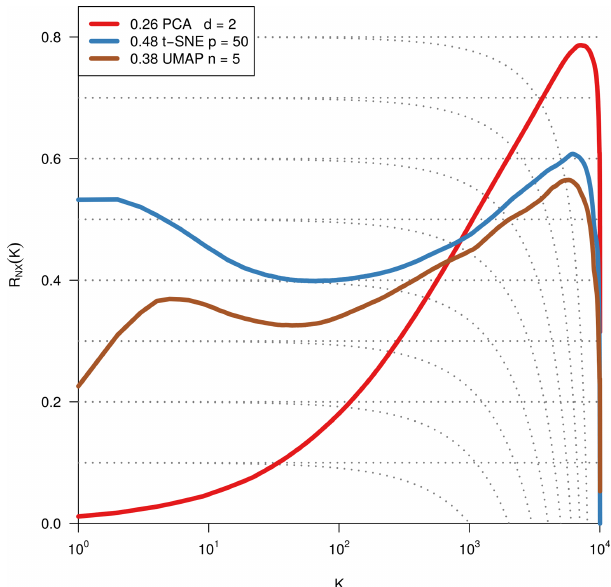
Figure B1. Quality assessment of dimensionality reduction techniques. To visualise and subsequently analyse the network space, we reduce its dimensionality. We compared PCA, t -SNE, and UMAP including various parameter settings (here: PCA’s leading two principal compo- nents, t -SNE with perplexity 30 and UMAP with n neighbours equal to 5 for two dimensions). The test statistic R NX (k) ( y axis) gives the improvement of the embedding of K -ary neighbourhoods ( x axis) over a random embedding. The area under the curves (preserving the log-scaled x axis) is given in the legend and gives an idea of the overall quality of the embedding (Lee et al., 2015). We chose t -SNE with perplexity 30, as it preserves best local neighbourhoods and performs well on larger distances.